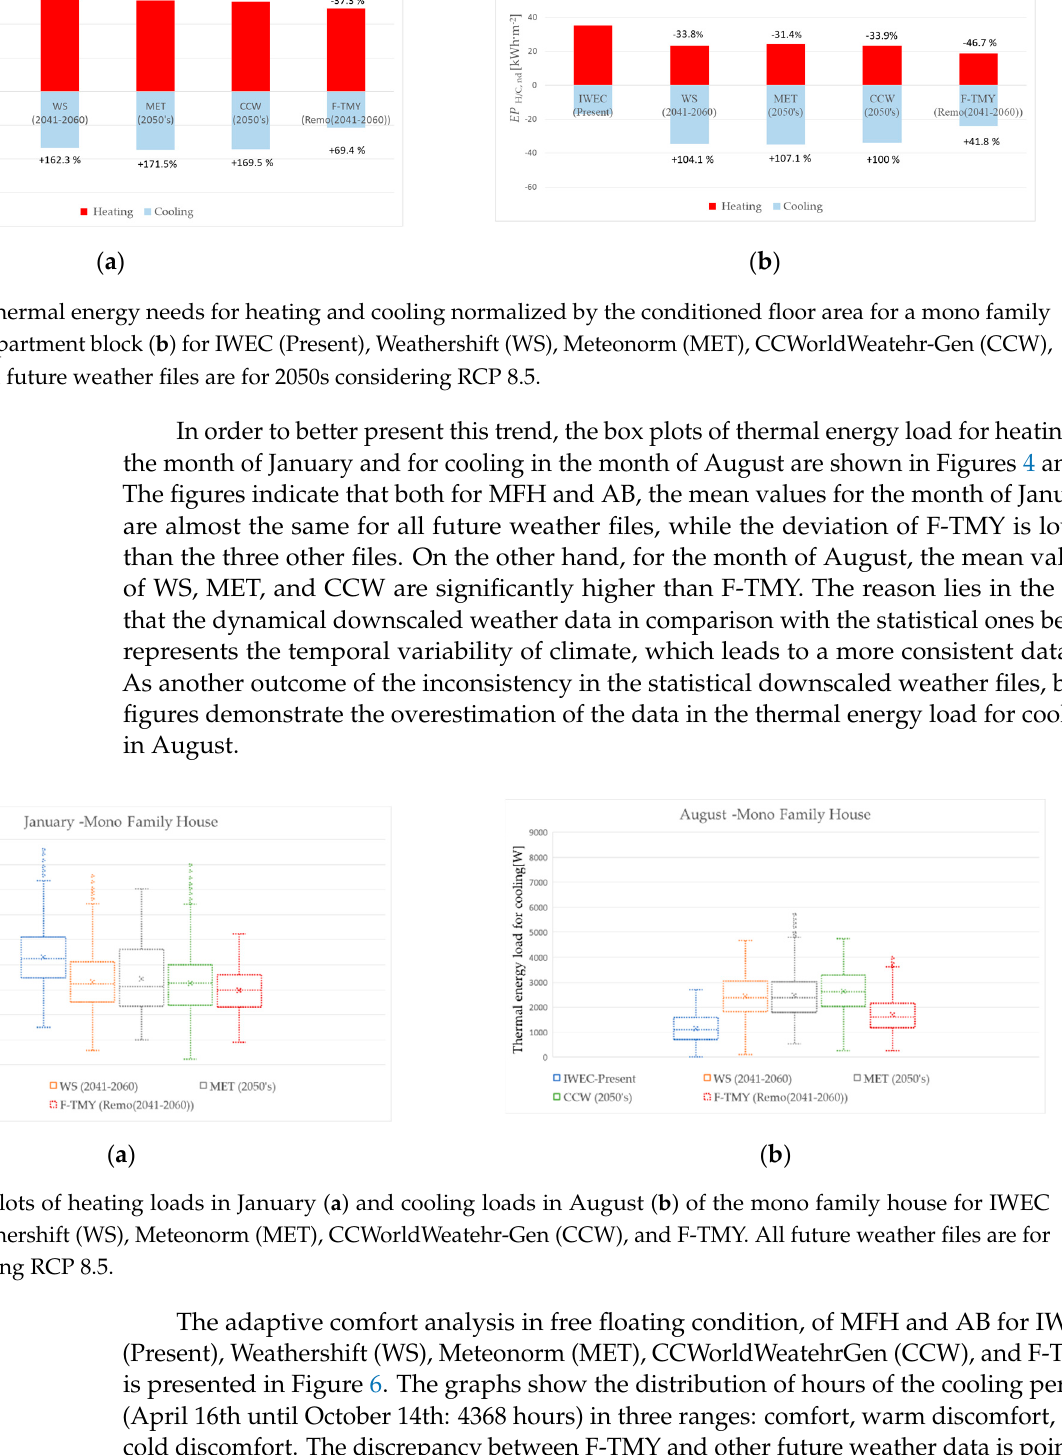
Figure 2. Boxplots of the outdoor dry-bulb temperature ( a ) and the global horizontal solar irradiance during daily hours ( b ) for IWEC (Present), Weathershift (WS), Meteonorm (MET), CCWorldWeatehr-Gen (CCW), and F-TMY. All future weather files are for 2050s considering Representative Concentration Pathway (RCP) 8.5.